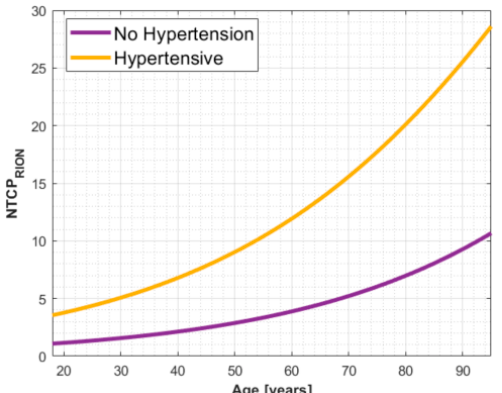
Figure 3. Visual representation of the final NTCP model formulation based on hypertension and age. Hypertensive as well as older patients are at larger risk for RION. This model applies to patients that receive at least 45 Gy RBE to the optic apparatus.